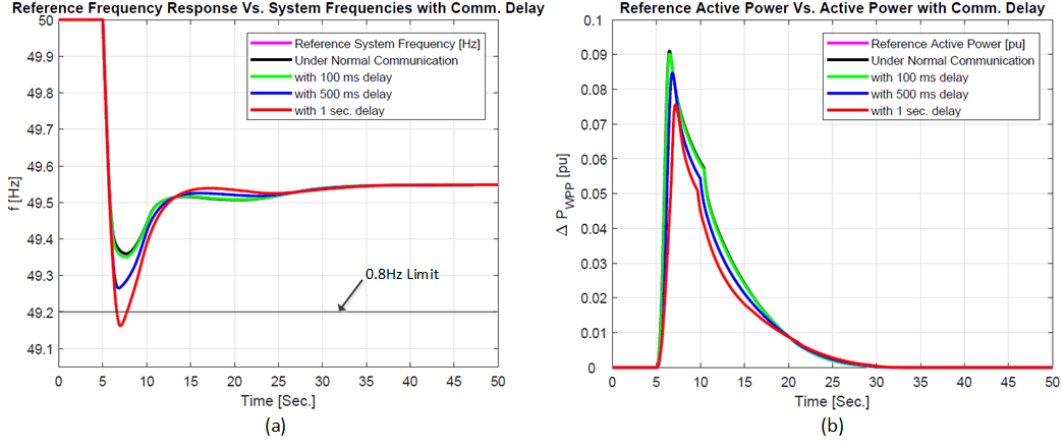
Figure 16. Figure showing at Full Load ( a ) System Frequency Response and ( b ) Total Active Power under different delay conditions compared to the Reference Frequency Response and Reference Active Power,